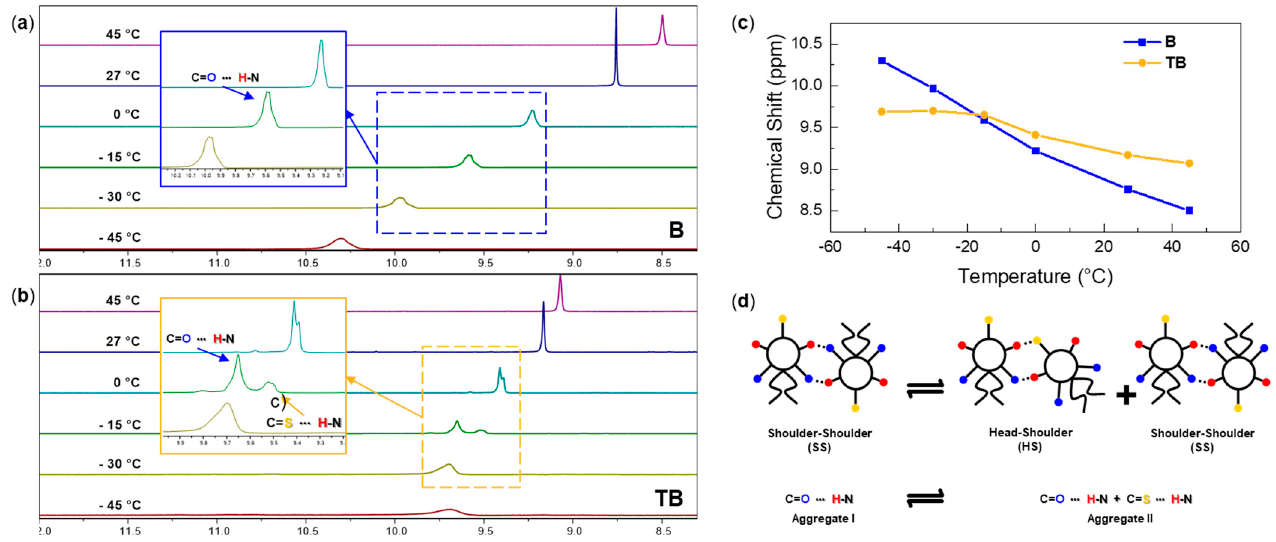
Figure 2. ( a , b ) Temperature-dependent 1 H NMR spectra of model compounds B and TB in CDCl 3 , ( c ) chemical shifts of N-H vs. temperature of the model compounds B and TB , and ( d ) the possible exchangeable assemblies in thiobarbiturate TB in CDCl 3 at T Coalescence = 0 °C.